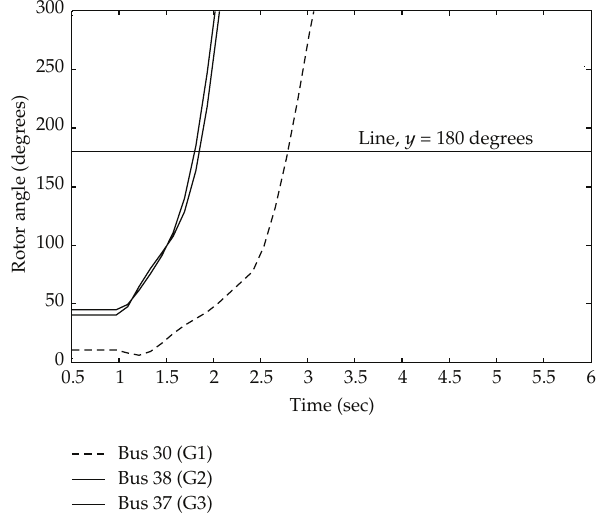
Figure 9: Individual COI-referred rotor angle of generators in Area